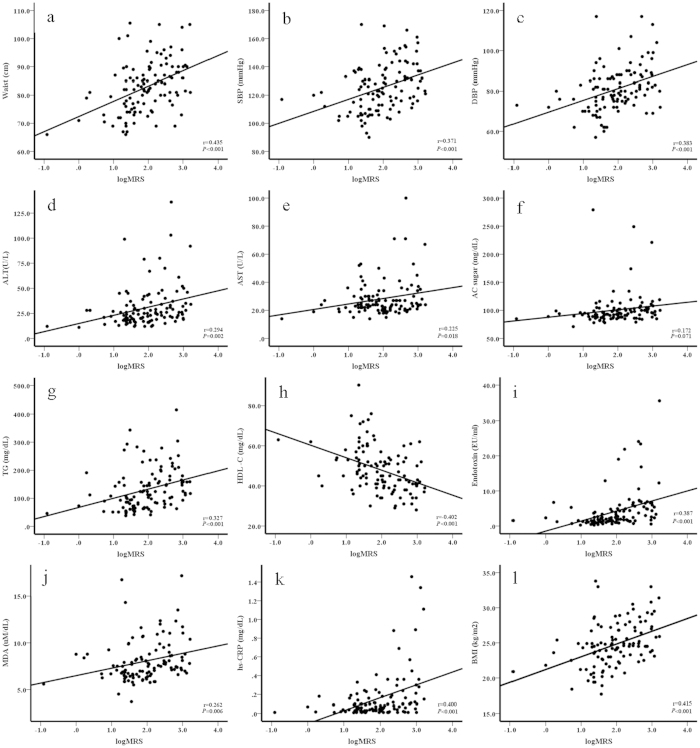
1H-MRS-measured fat content correlates with components of metabolic syndrome, oxidative stress, hs-CRP and endotoxin. Positive associations between 1H-MRS-measured fat content and waist size (a), systolic blood pressure (SBP) (b), diastolic blood pressure (DBP) (c), alanine transaminase (ALT) (d), aspartate transaminase (AST) (e), fasting glucose (AC) (f), triglyceride (TG) (g), high-density cholesterol (HDL-C) (h), endotoxin (i), malondialdehyde (MDA) (j), high-sensitivity C-reactive protein (hs-CRP) (k), and body mass index (BMI) (l).